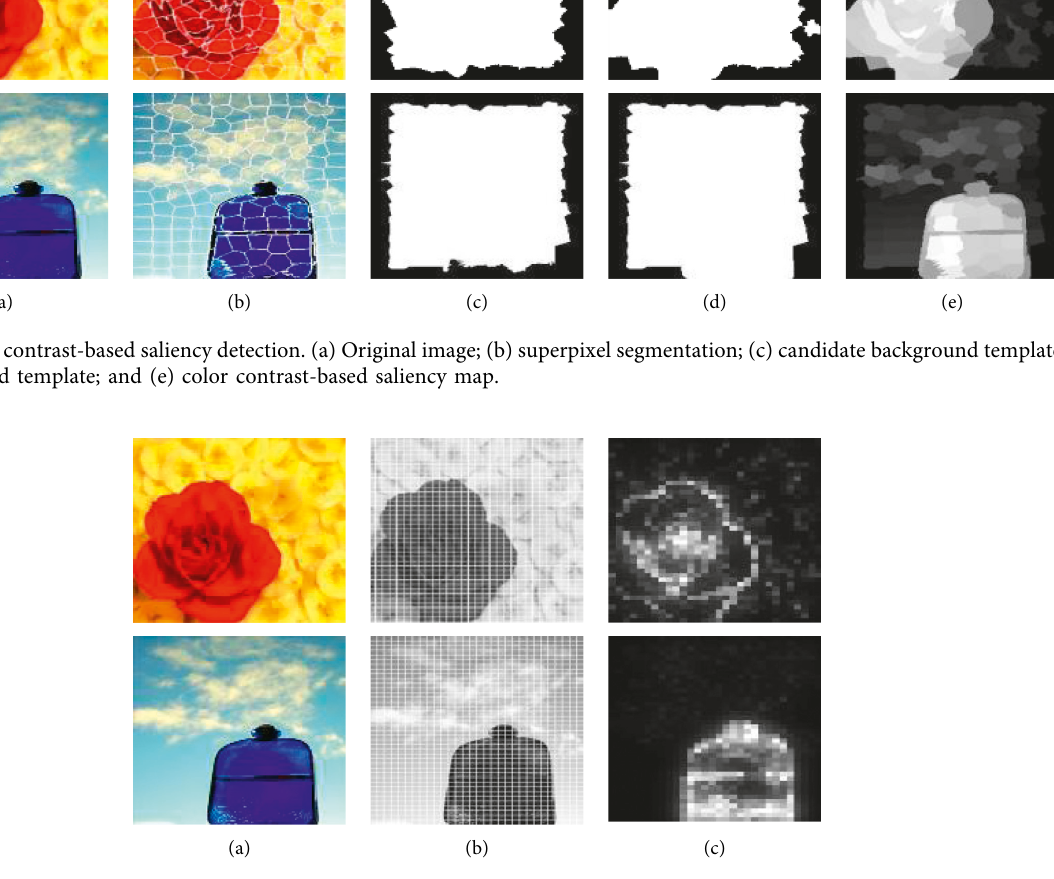
Figure 3: Hash fingerprint-based saliency detection. (a) Original image; (b) image division; and (c) hash fingerprint-based saliency map.